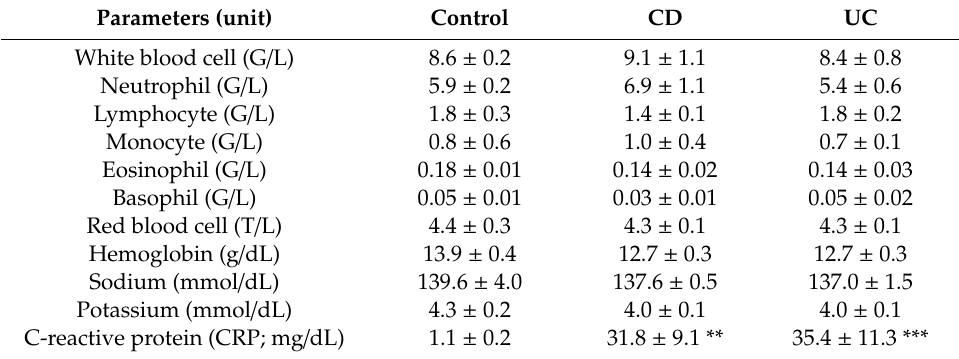
Table 1. Laboratory findings of control subjects and IBD patients enrolled in the study.